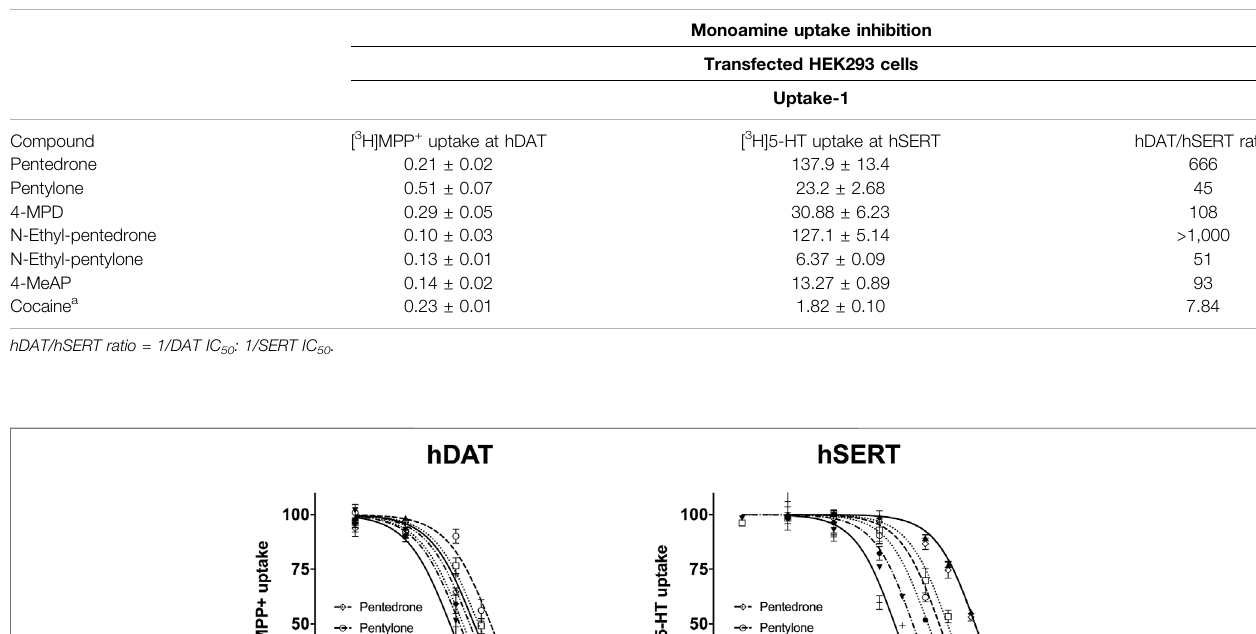
TABLE 1 | Potency of substituted cathinones and standard compounds at monoamine transporters. Monoamine uptake inhibition: values are IC 50 given in µM (mean ± SEM).